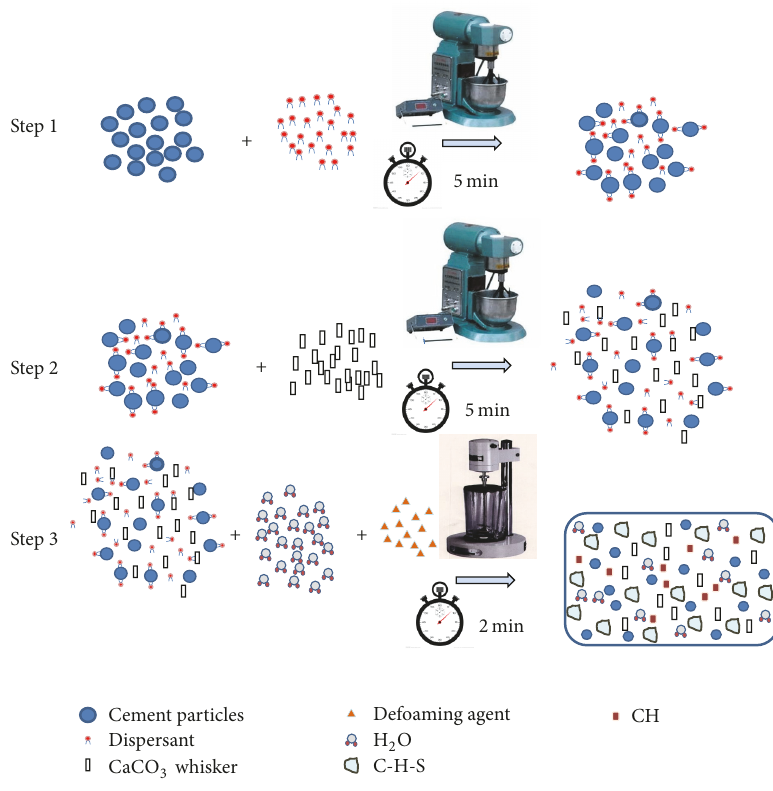
Figure 1: The mixing procedure for fresh cement paste